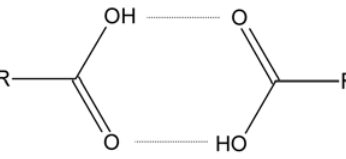
Figure 9. Pair-wise association of two carboxylic acids, a common hydrogen bond